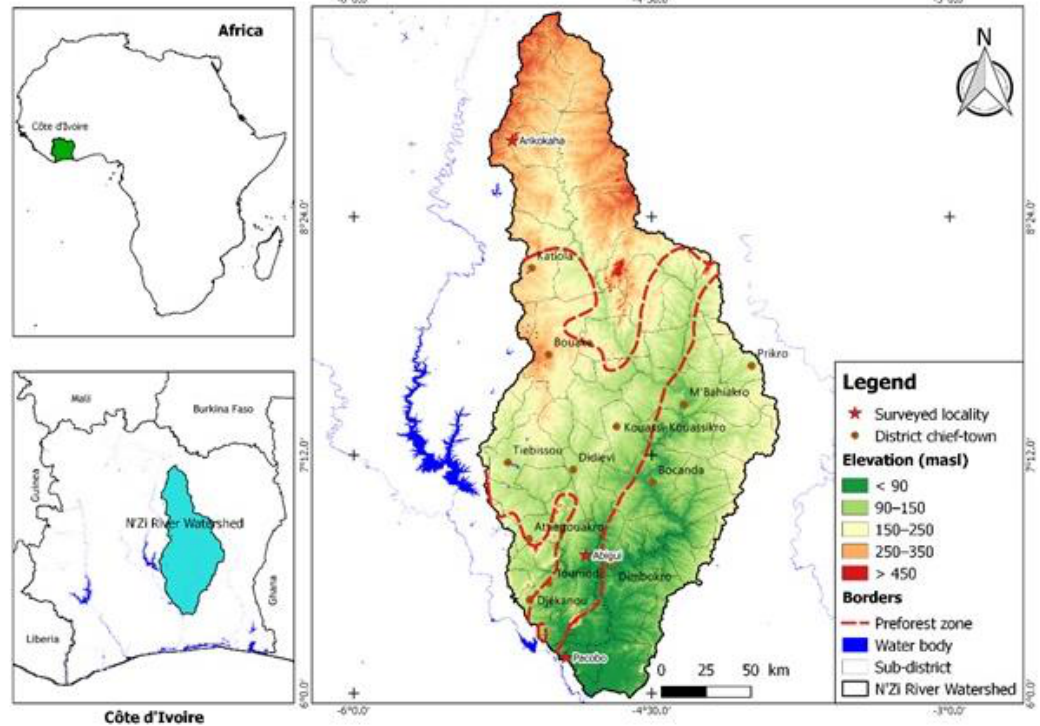
Fig. 1. Map of the N’Zi River